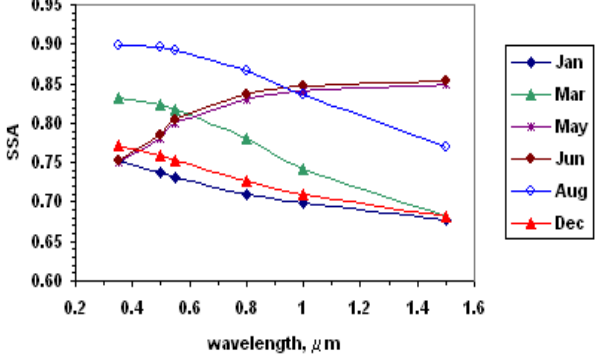
Fig. 7. Effect of change in BC concentration over AOD, SSA and asymmetry factor estimated using OPAC urban aerosol model.